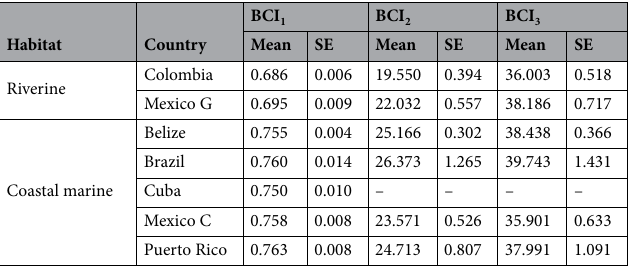
Table 2. BCI values fitted to wild Antillean manatees with non-linear robust regression by country of capture.